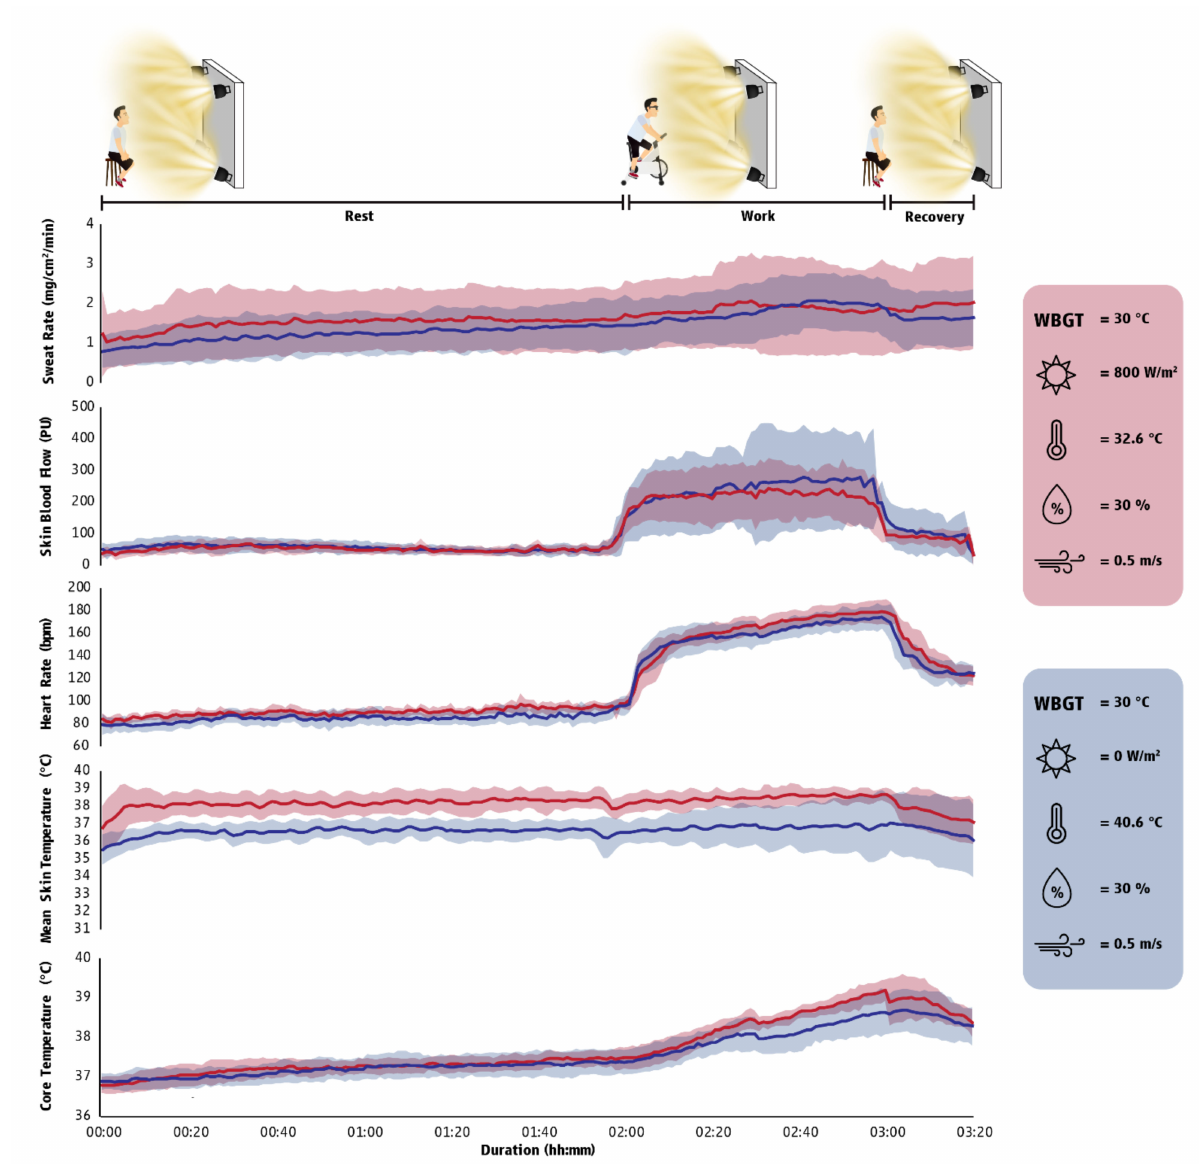
Figure 3. Physiological responses (mean ± SD) during exposure in a hot environment (30 ◦ C WBGT). The first two hours (00:00 to 02:00) illustrate the fluctuation of physiological responses in resting conditions, the third hour (02:00–03:00) illustrate physiological responses during exercise/work, while the final 20 min (03:00–03:20) show the responses during recovery time. Red indicates a hot outdoor environment, while blue indicates a hot indoor environment. Sweat rate corresponds to the average sweat rate from the forehead, arm (bicep), and thigh (quadricep) as measured using the ventilated capsule technique, expressed in milligrams per centimeter square per minute. Skin blood flow as measured by laser-Doppler flowmetry corresponds to the average skin blood flow from the forearm (brachioradialis) and leg (gastrocnemius), expressed in perfusion units. Heart rate is expressed in beats per minute. Mean skin temperature estimated from arm, chest, thigh, and leg skin temperatures, expressed in degrees Celsius. Core temperature corresponds to gastrointestinal temperature, expressed in degrees Celsius. Effect sizes for all comparisons between outdoor and indoor environments can be found in Table